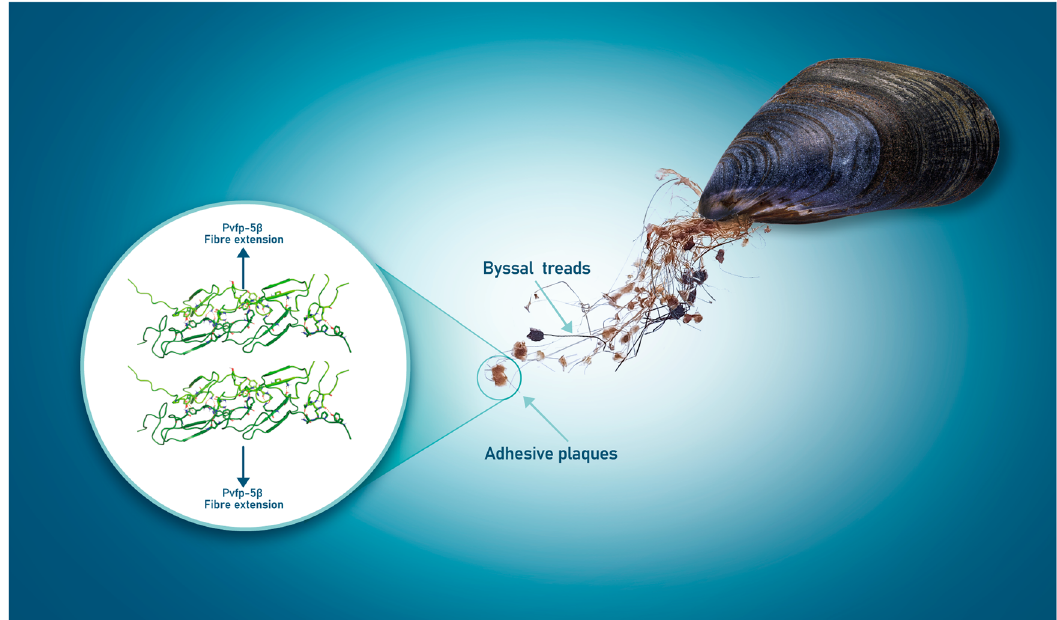
Fig. 5 Pvfp-5 β self-assembly in mussel byssal plaques. The elongated shape of the Pvfp-5 β and the exposure of many interaction hotspots are ideal for fi ber formation. Different units might pile up interacting in a way perpendicular to the main axis of the fi bers, as in the cross- β of an amyloid fi